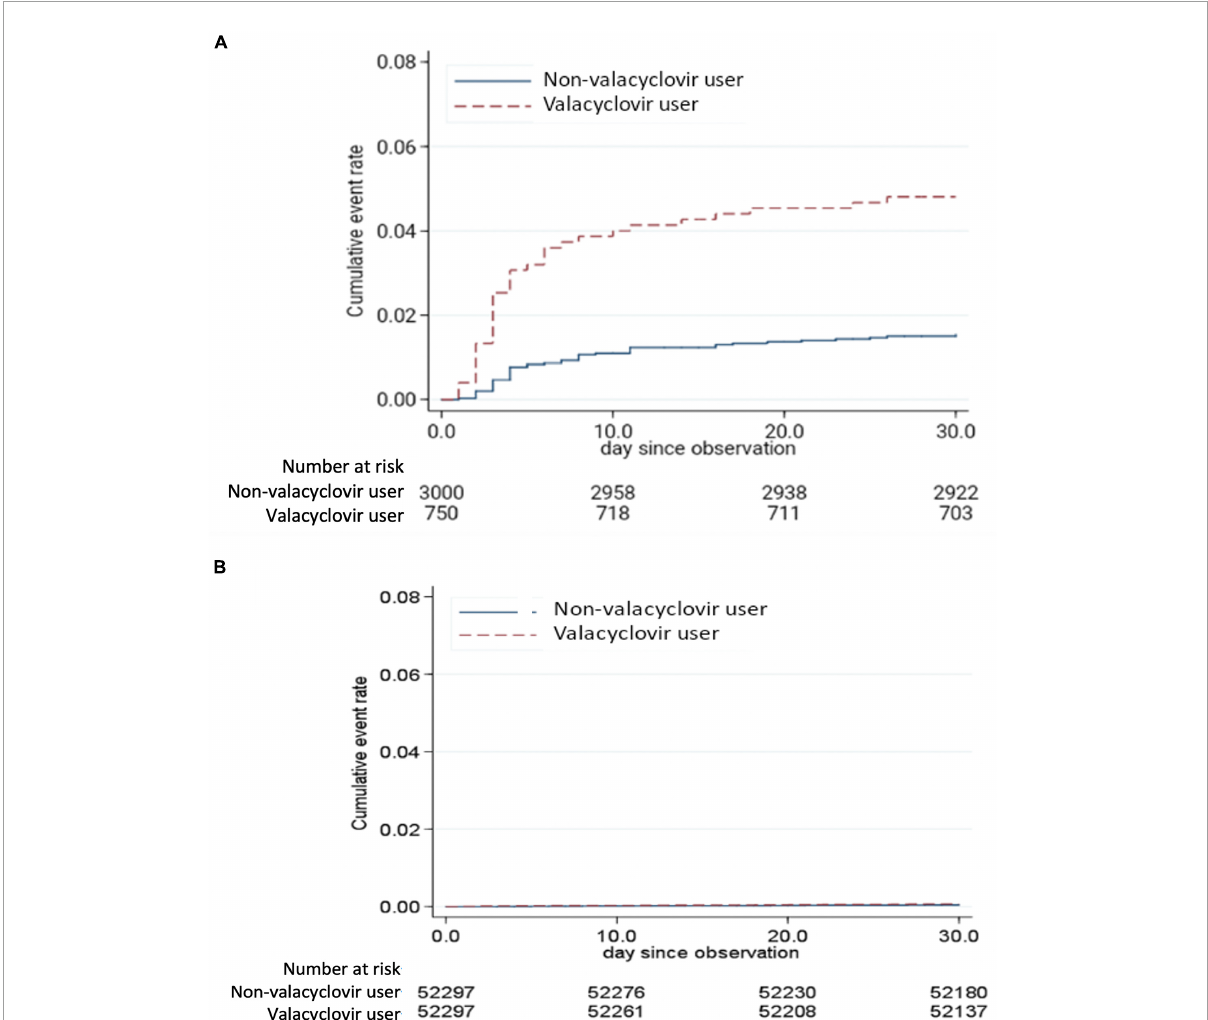
FIGURE2 Kaplan–Meier failure curve of altered mental status in the end-stage renal disease cohort (A) and normal renal function cohort (B) over a 30-day follow-up period.